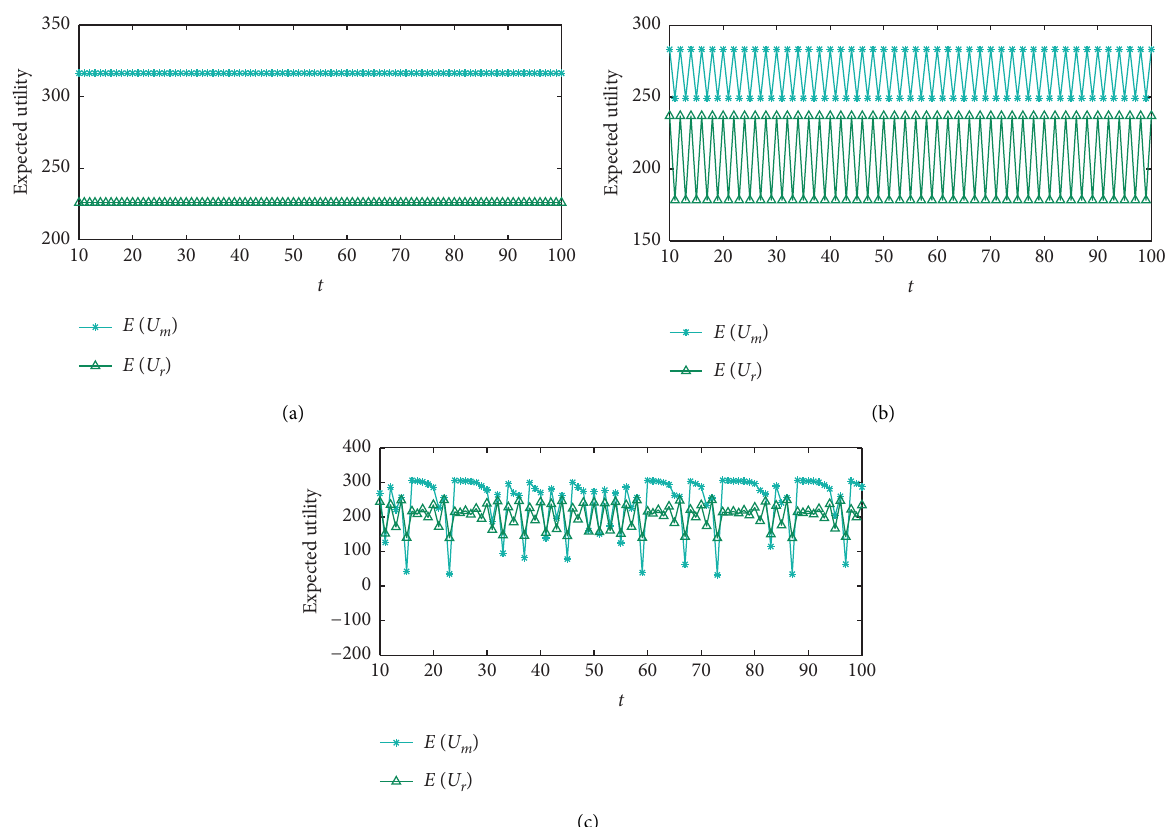
Figure 14: The evolution of expected utility over time in different periods. (a) δ